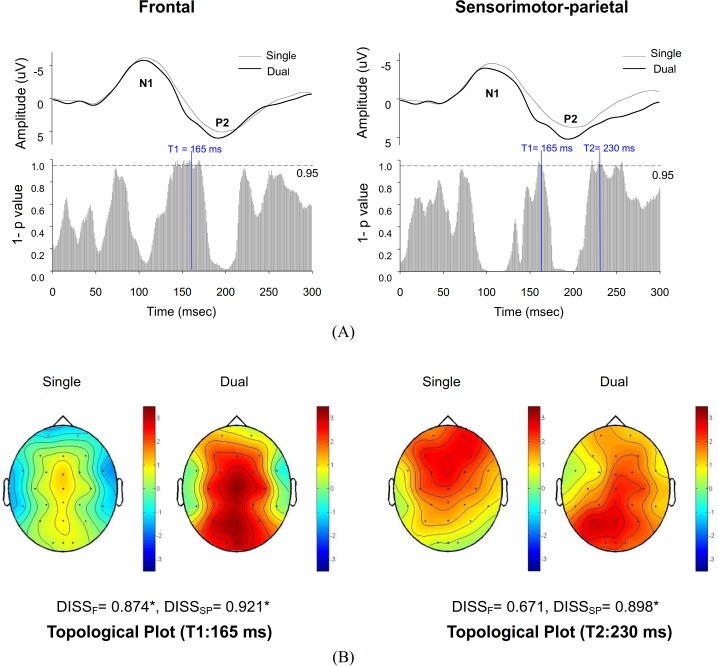
Topological ERP analysis of the single-posture and dual-task conditions.(A) Millisecond-by-millisecond topological ANOVA (TANOVA) results. T1 is a time point that exhibits ERP topological differences for the frontal and sensorimotor-parietal areas between the single-posture and dual-task conditions. T2 is a time point that only exhibits ERP topological differences in the sensorimotor-parietal areas between the two conditions. (B) Scalp topologies and global dissimilarity (DISS) at T1 and T2 for the single-posture and dual-task conditions. (*: p < 0.05).